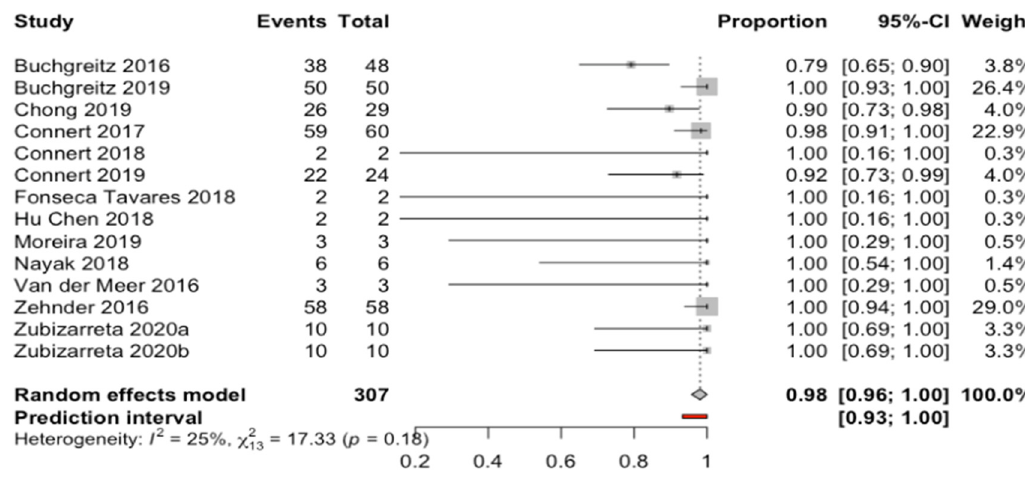
Figure 2. Forest plot of root canal location success rate between the studies selected. The horizontal axis expresses the root canal proportion success rate of each study.